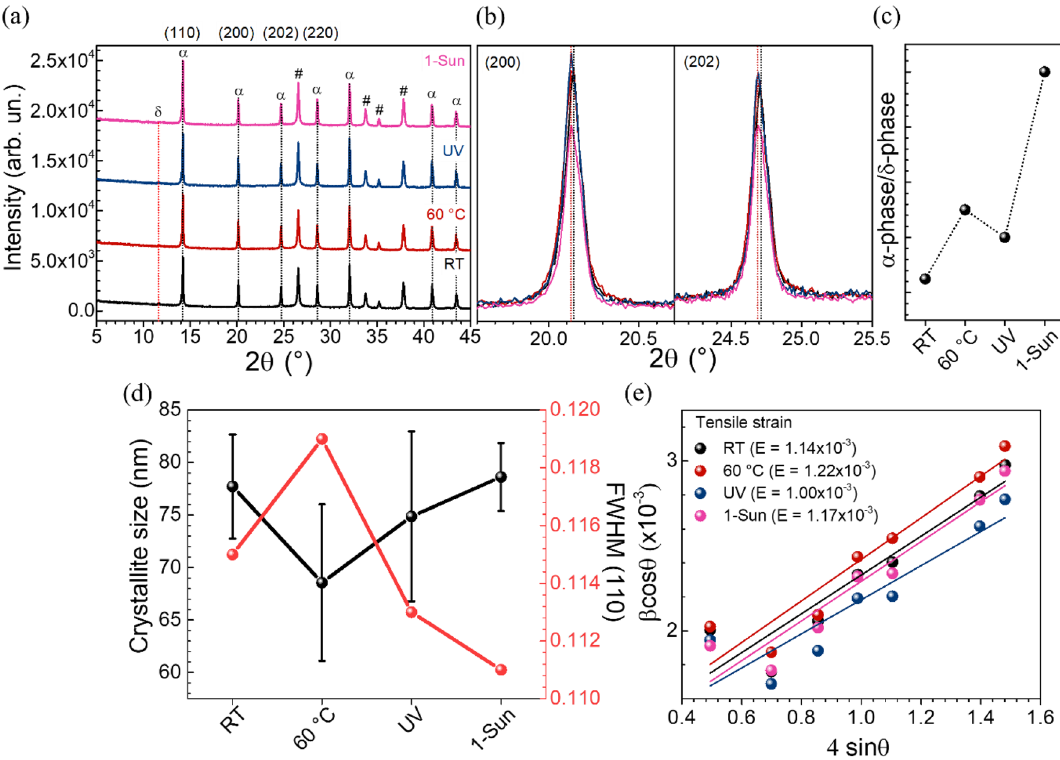
Figure 1. ( a ) X-ray diffraction patterns of Cs 0.05 FA 0.73 MA 0.22 Pb(I 0.77 Br 0.23 ) 3 films with different stimuli applied into perovskite solutions, where active perovskite phase ( ⍺ ), inactive perovskite phase (δ), and FTO substrate (#) signatures are labeled. ( b ) Narrow view of (200) and (202) perovskite crystal planes. ( c ) The ratio of the active phase and the inactive perovskite phase intensities measured at 14.21° and 11.57°. ( d ) Crystallite sizes and (110) full-width at half maximum (FWHM). ( e ) Williamson-Hall analysis of perovskite films with different applied